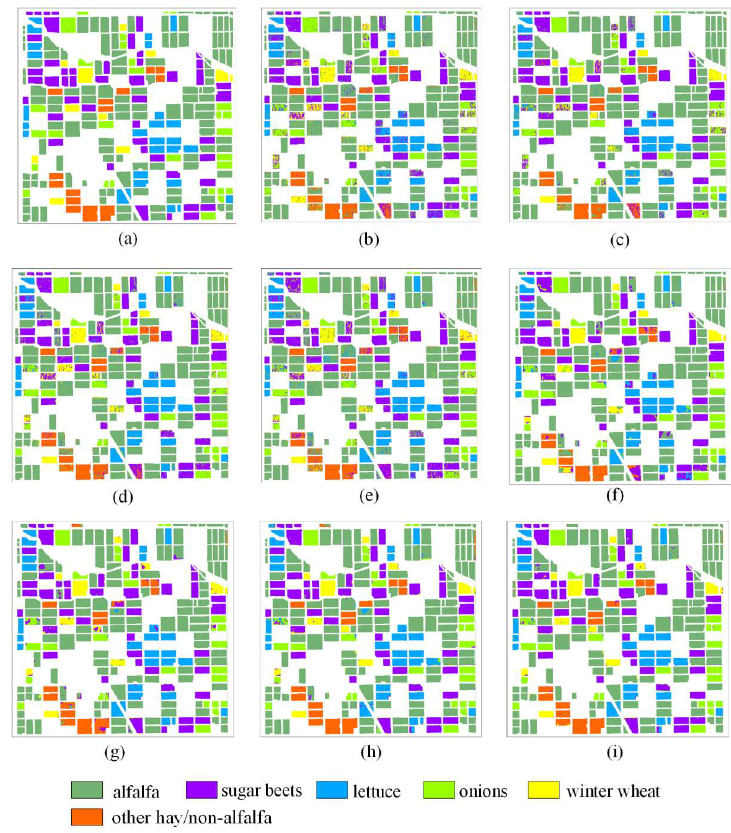
Figure 7. Maps of study area 1: ( a ) Ground truth map, ( b ) SVM, ( c )RF, ( d ) Conv1D, ( e ) LSTM, ( f ) Net A, ( g ) Net B, ( h ) Net C, and ( i ) DSCRNN. Table 4. Results of study area 1.